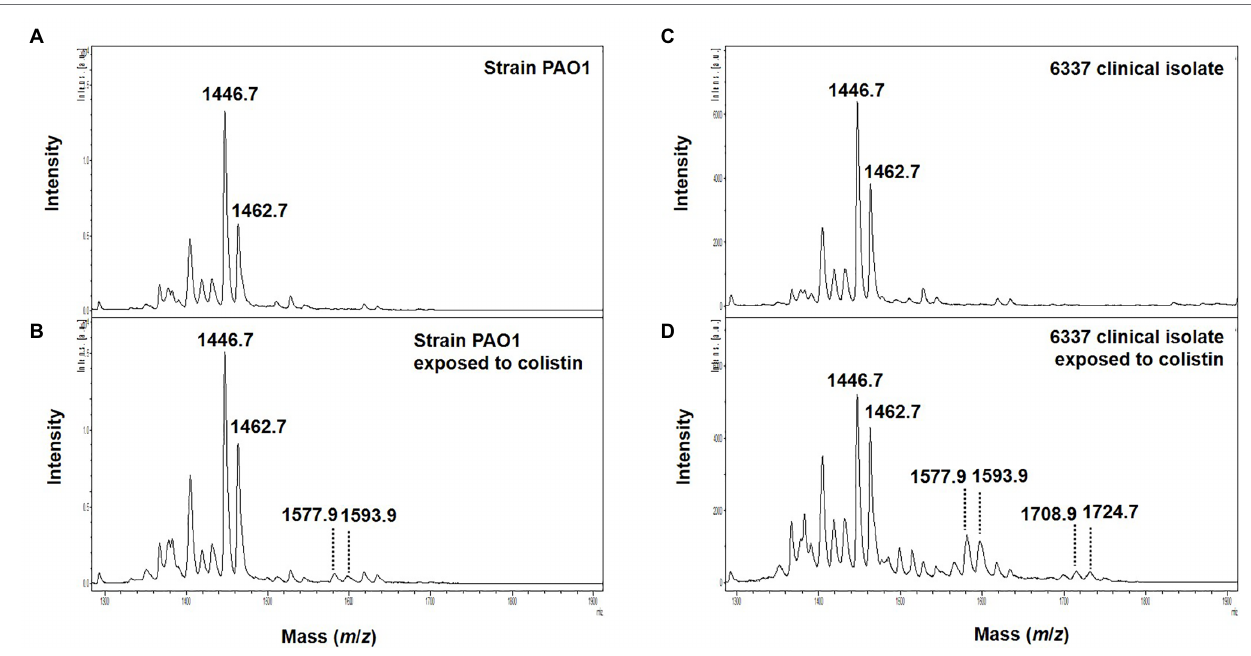
FIGURE 2 | Representative mass spectra of colistin induced susceptible and modified P. aeruginosa lipid A acquired using the linear negative-ion mode of a MALDI Biotyper Sirius system (Bruker Daltonics). (A) Susceptible P. aeruginosa PAO1 lipid A is detected as two major peaks at m / z 1,446.7 and m / z 1,462.7. (B) Colistin induced susceptible P. aeruginosa PAO1 lipid A with additional peaks at m / z 1,577.9, m / z 1,593.9 corresponding to L -Ara4N addition on the penta-acylated lipid A (peaks at m / z m / z 1,446.7 and m / z 1,462.7). (C) Lipid A from colistin-resistant P. aeruginosa clinical isolate 6,337 is detected as two major peaks at m/z 1,446.7 and m / z 1,462.7. (D) Colistin induced colistin-resistant P. aeruginosa clinical isolate 6,337 lipid A with additional peaks at m / z 1,577.9, m / z 1,593.9, m / z 1,708.9, and m / z 1,724.9 corresponding to L -Ara4N addition on the penta-acylated lipid A (peaks at m / z m / z 1,446.7 and m / z 1,462.7).